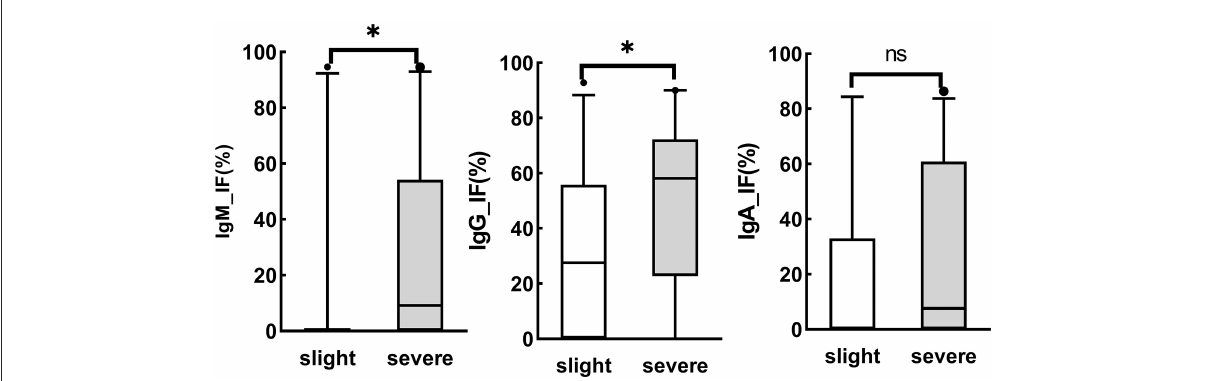
FIGURE2 Association of brain injury and Ig synthesis. Asymptomatic neurosyphilis ( n = 5), meningeal syphilis ( n = 11), meningovascular syphilis ( n = 6), and ocular syphilis ( n = 3) were divided into the slight group, while general paresis ( n = 38) and tabes dorsalis ( n = 1) were classified into the severe group. ns, no significant. * P < 0.05.